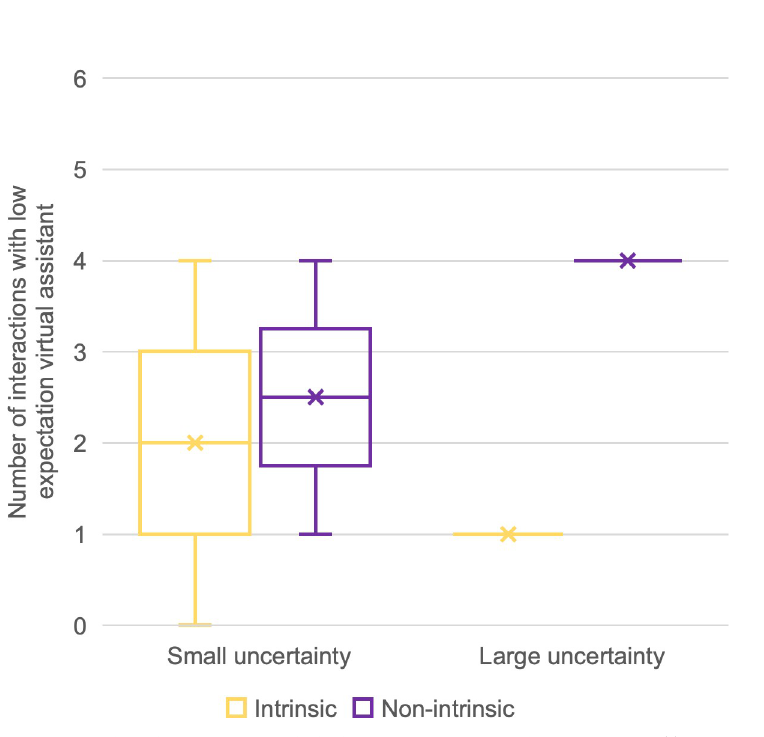
PLOS ONE | https://doi.org/10.1371/journal.pone.0250326 April 23,